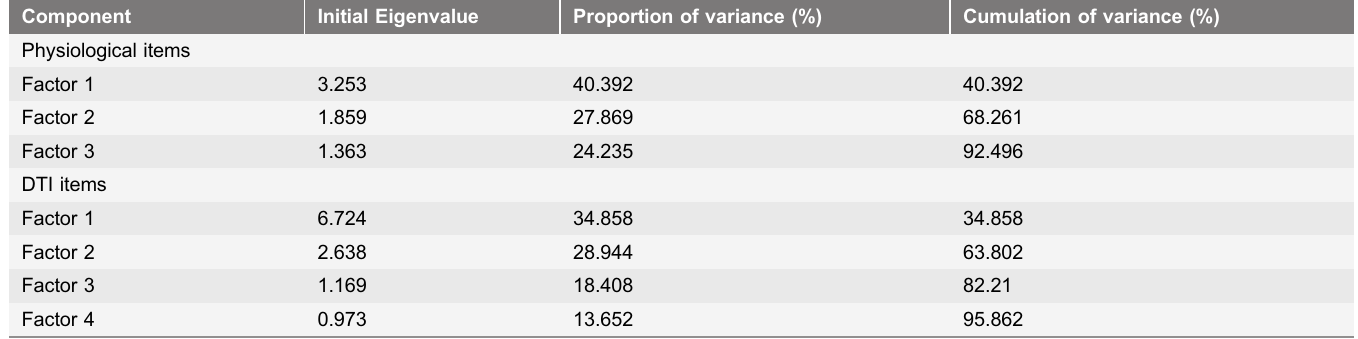
Table 6. Variance by principal component and rotational sum.